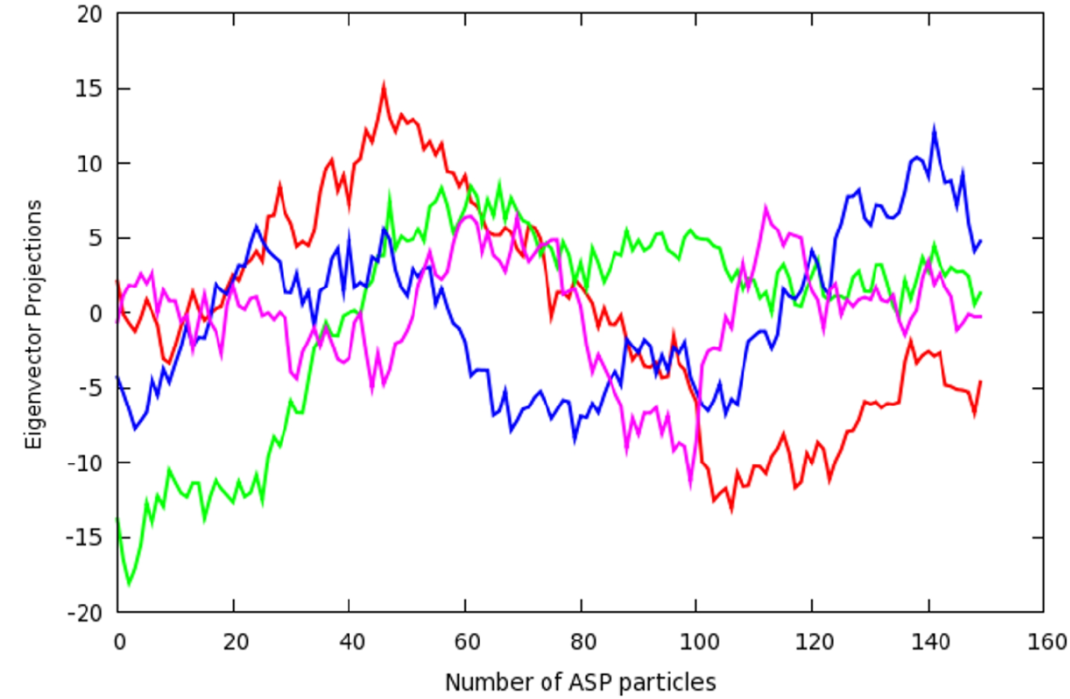
Figure 10. Projections of the first 4 eigenvectors for the PCA analysis of CDK5 for the insertion of 150 ASP particles. The graphs are coloured: eigenvector 1 (red), eigenvector 2 (green), eigenvector 3 (blue), eigenvector 4